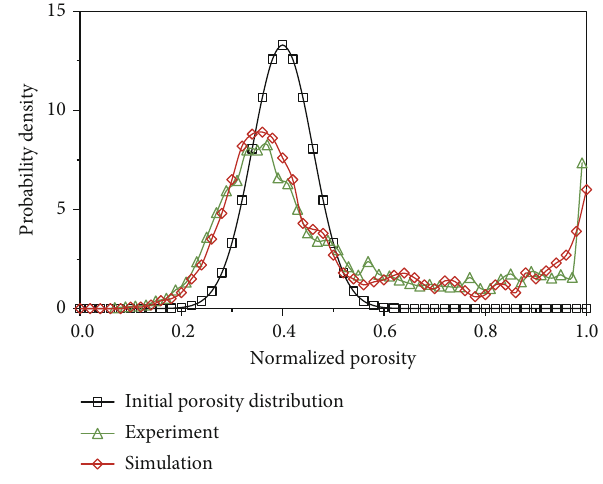
Figure 1: Comparison of probability density of normalized porosity after steady state is achieved between experimental and simulation results.